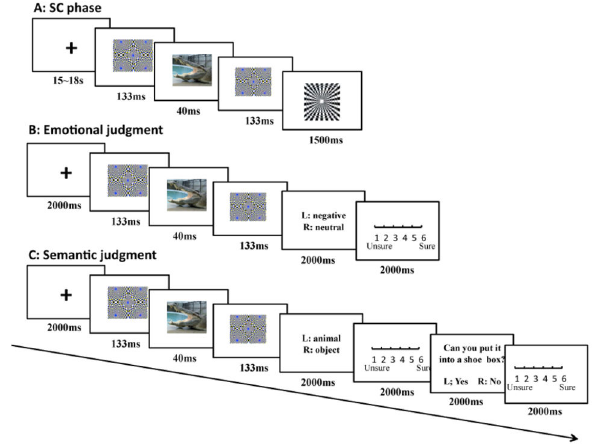
Figure 4. The procedure of Experiment 3. The sandwich- mask paradigm was used to present the pictures (A). The following emotional judgment (B) and semantic judgment (C) tasks were used to assess the participants’ levels of conscious